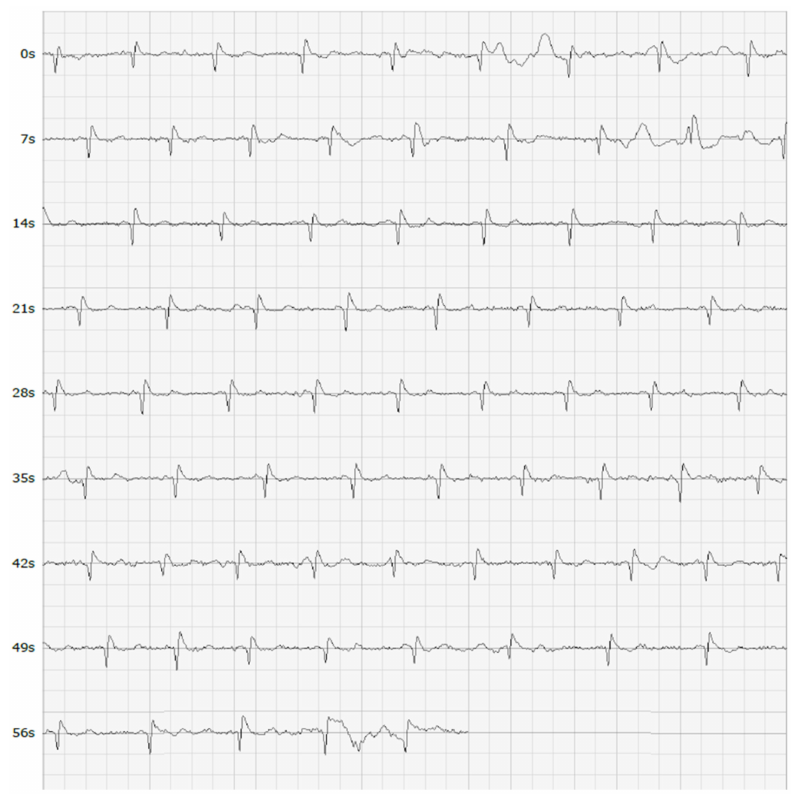
Figure 3. A single lead ECG tracing that was recorded as not